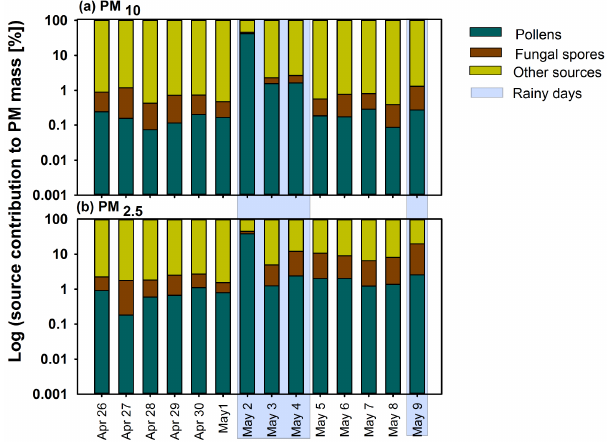
Figure 5. Apportionment of PM 10 mass (a) and PM 2 . 5 mass (b) during the spring of 2013 to pollens and fungal spores using CMB modeling.